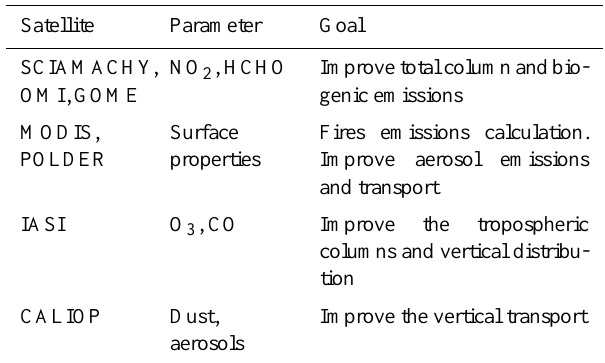
Table 9. Satellite data used for model/data comparisons and analy-